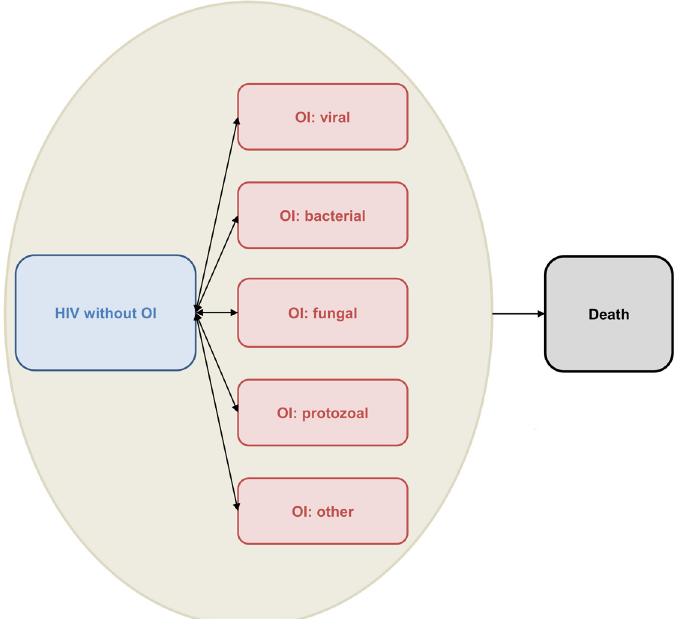
Fig 1. Model structure. HIV: Human Immuodeficiency Virus; OI: Opportunistic Infection.